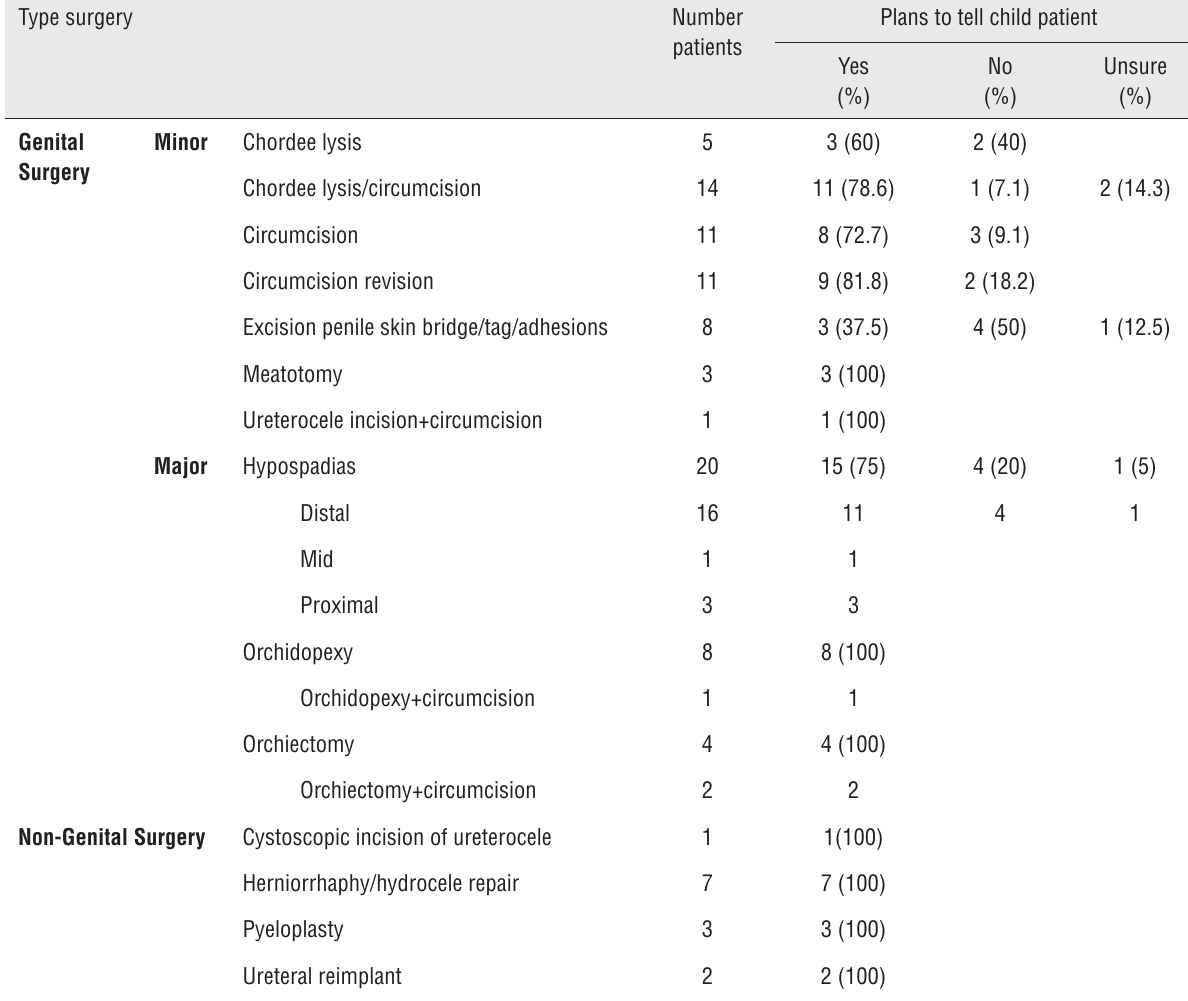
Plans to tell child patient patients Yes No Unsure (%) (%) (%)